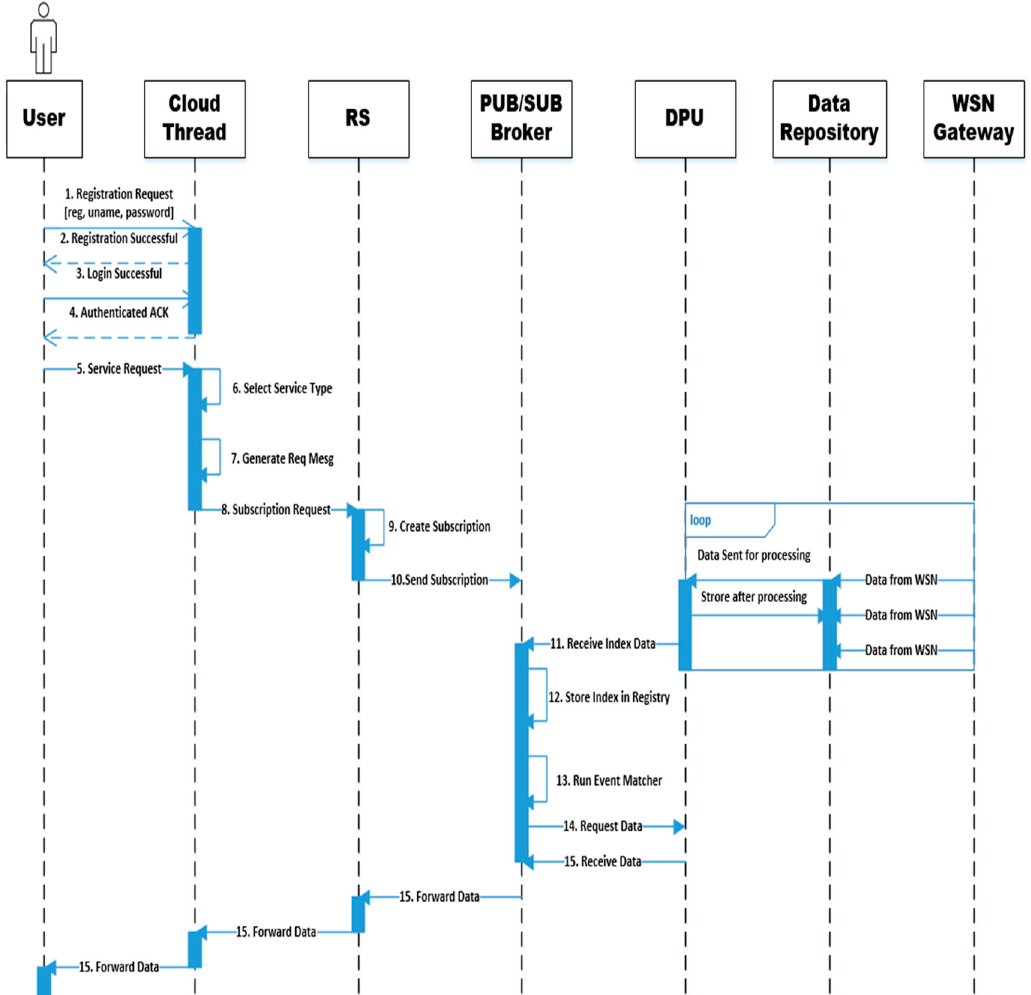
Figure 3. Sequence diagram of the proposed framework.